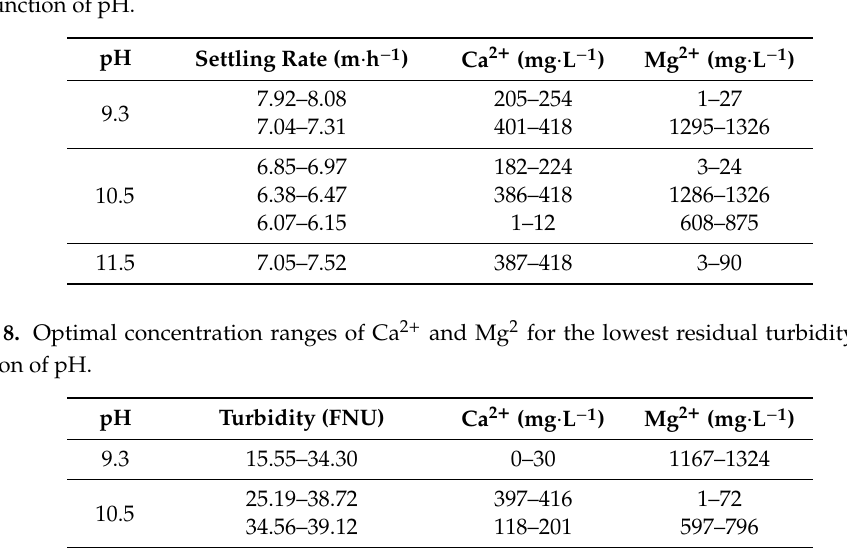
Table 7. Optimal concentration ranges of Ca 2 + and Mg 2 for the highest mine tailings settling rate (Sr) as a function of pH.